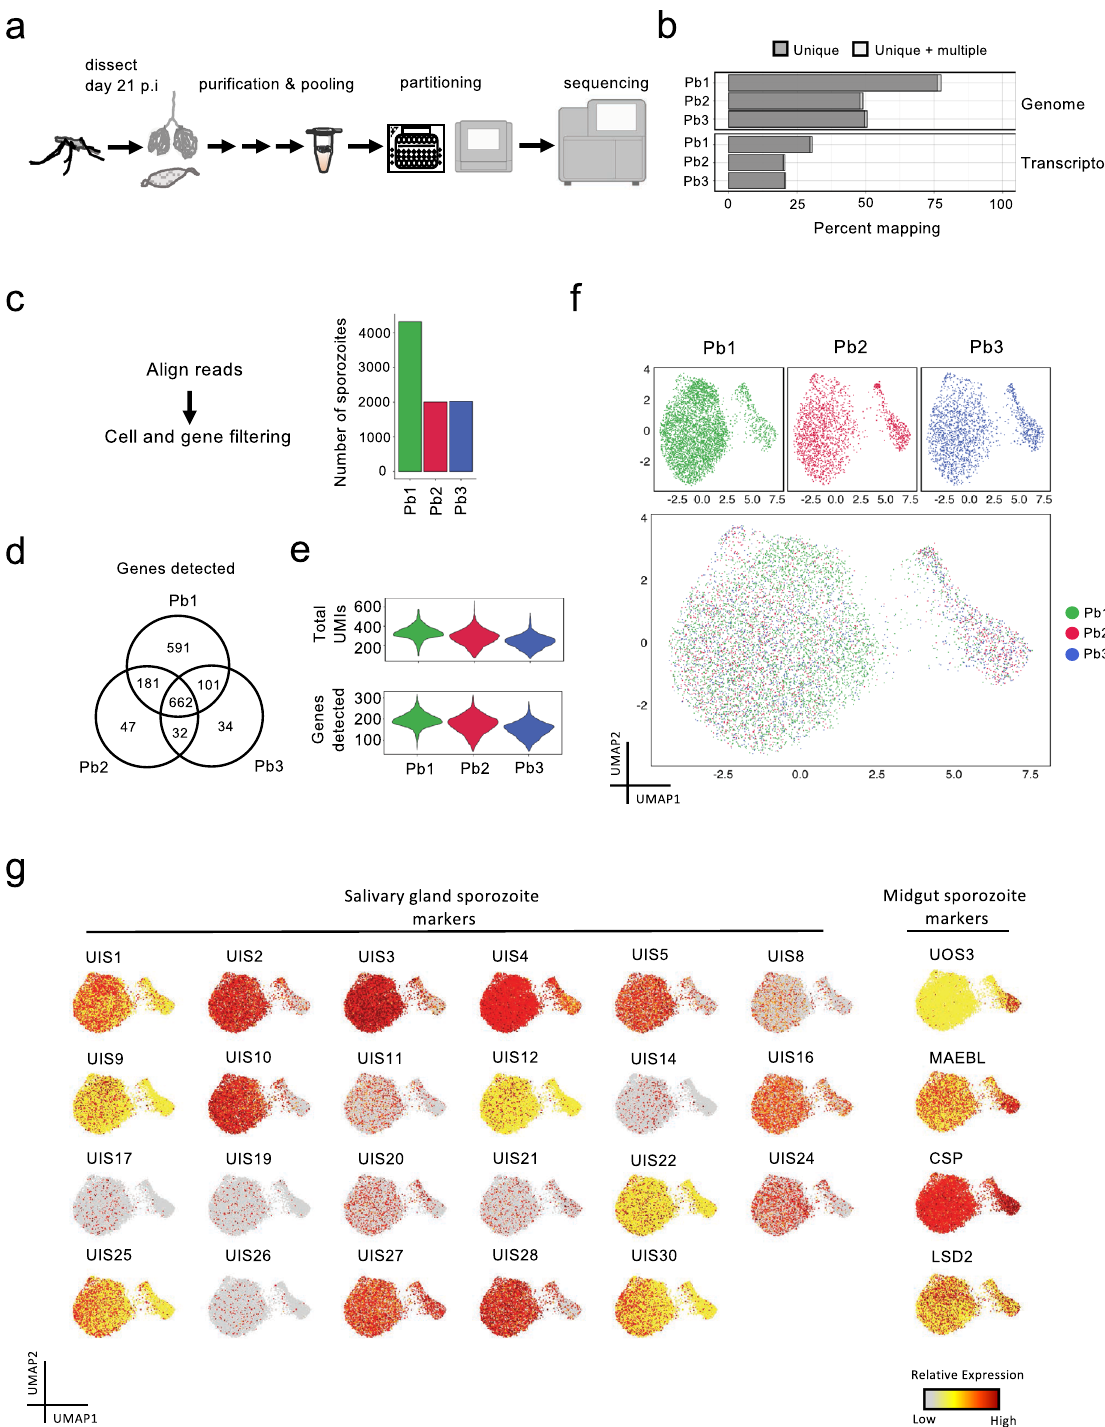
Figure 1. Mapping, quality control, and integration of P. berghei sporozoite 10 × scRNA-seq data. ( a ) Schematic illustrating the workflow used for scRNA sequencing of P. berghei sporozoites. ( b ) Number of P. berghei reads mapping to the genome (top) and transcriptome (bottom) across the three libraries. ( c ) Number of sporozoite transcriptomes analyzed post cell and gene filtering. ( d ) Number of unique and overlapping transcripts across the three single-cell library preparations. ( e ) Violin plots showing the distribution of total UMIs (top) and unique transcripts (bottom) across each of the three replicates. ( f ) UMAP representations displaying integrated scRNA-seq sporozoite datasets individually (top panels) and overlaid (bottom panel). ( g ) UMAP representations displaying the expression of UIS markers (left) and MID sporozoite markers (right). See Supplementary Table S1 online for gene descriptions of the first 30 UIS